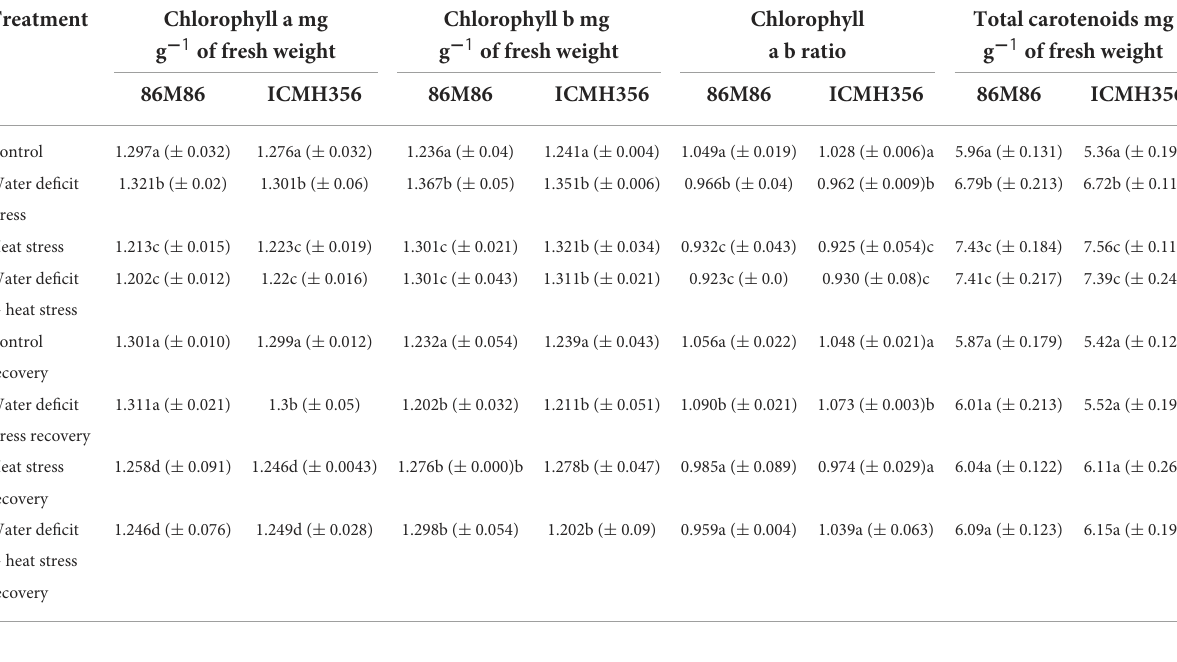
TABLE 3 Chlorophyll a, Chlorophyll b, the ab ratio, and total carotenoids in two varieties of pearl millet under water-deficit stress and heat stress in isolation and in combination and after recovery from stress.